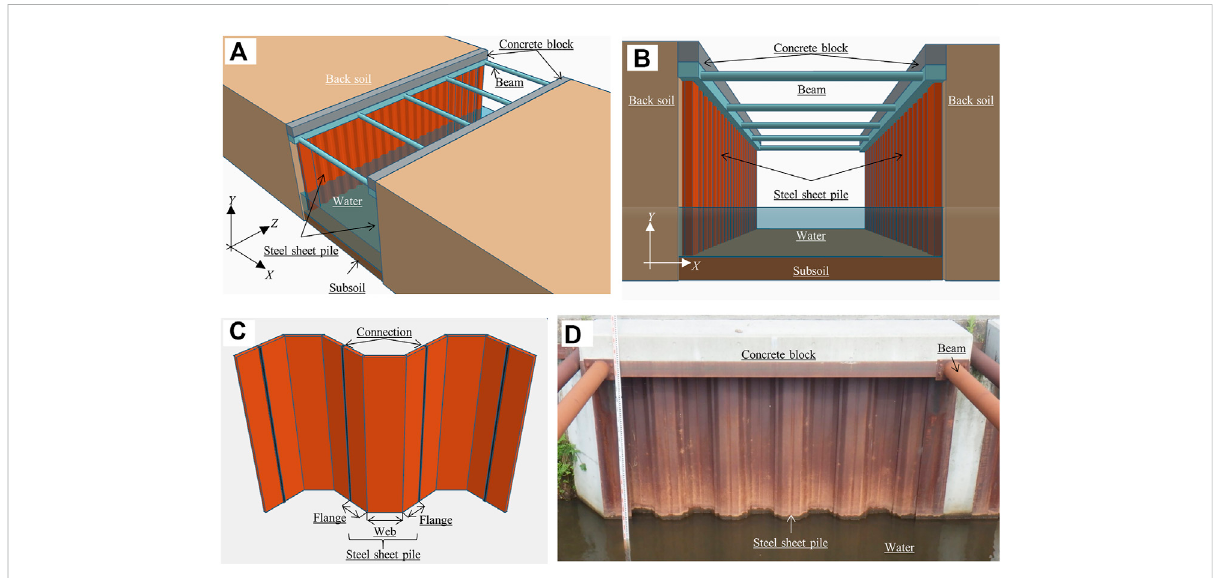
FIGURE 1 Steel sheetpilesapplied asacanalstructure. (A) A steelsheetpilecanalwithbeams. (B) Acrosssectionofasteelsheetpilecanal. (C) Steelsheet piles. (D) In-service steel sheet piles in a drainage